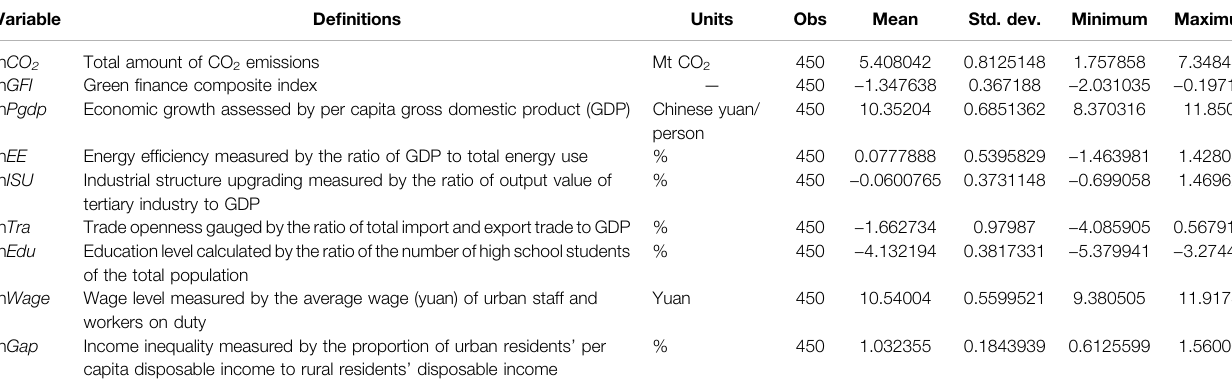
TABLE 1 | De fi nitions and descriptive statistics of the selected